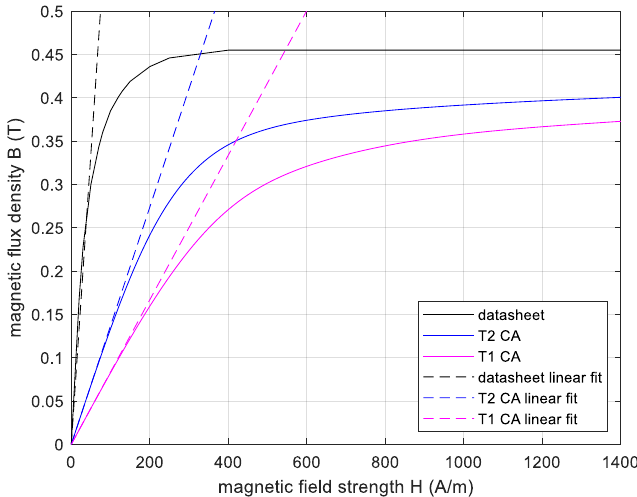
Figure 15. Equivalent anhysteretic B ( H ): datasheet and measurement (solid line), linear interpolation (dashed line).